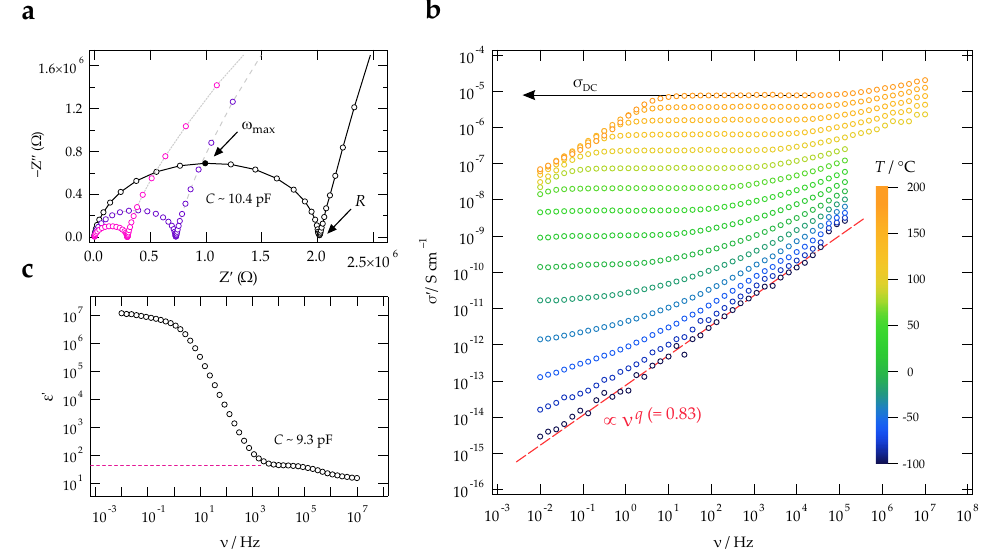
Figure 4. ( a ) Nyquist plots of the complex impedance of Sr 1 − x Y x F 2 + x with x = 0.3 recorded at the temperatures indicated. The solid lines are to guide the eye. The depressed semicircles indicate correlated ion movements in the ternary fluoride; from ω max (= ν max 2 π ) and R electrical capacities, C = 1/ ( ω max R ) , in the order of 10 pF were estimated indicating that the overall electrical response is mainly given by bulk properties rather than by ion-blocking grain boundary contributions; ( b ) Conductivity isotherms of Sr 0.7 Y 0.3 F 2.3 recorded from − 100 °C to + 180 °C in steps of 20 °C. The pronounced plateaus at intermediate frequencies contain the DC conductivity σ DC , as indicated; ( c ) Real part, (cid:101) (cid:48) , of the complex primitivity as a function of frequency. Above 10 3 Hz the bulk response is seen; the capacity associated with that response is in the order of 10